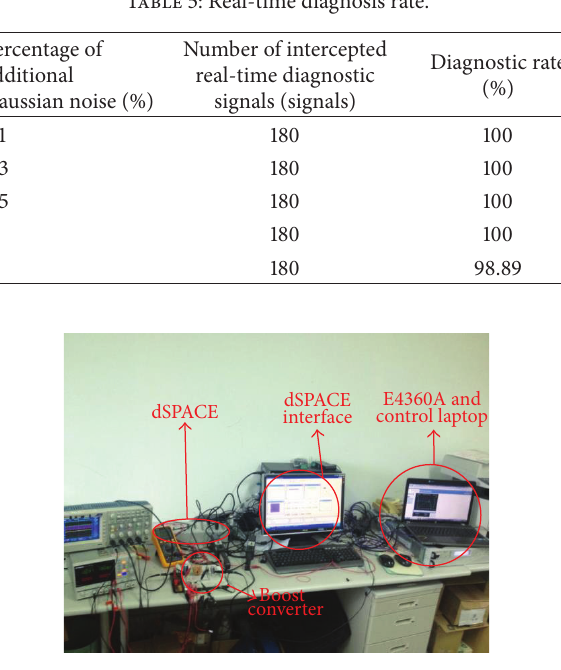
Figure 11: System hardware